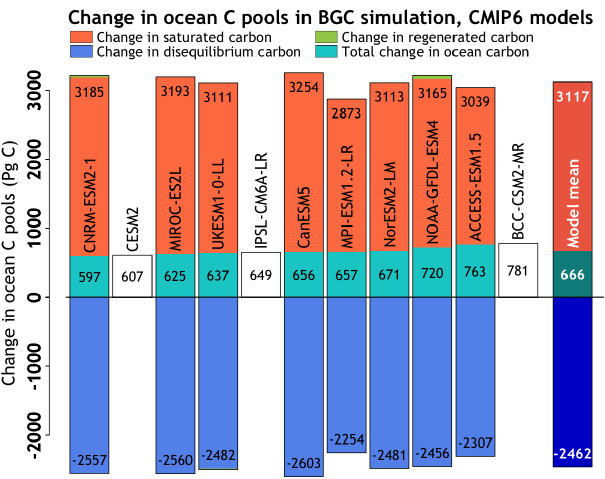
Figure 12. Carbon uptake over the ocean in the biogeochem- ically coupled simulation, used to calculate the ocean carbon– concentration feedback and its partitioning into saturated, dise- quilibrium, and regenerated carbon pools across the participating CMIP6 models (left) using Eq. (12). No partitioning is shown for models for which 3D ocean fields were not available, and the results of these models are not used in calculating the model mean values (right). The sum of the partitions does not exactly match the total ocean uptake diagnosed from the air–sea fluxes due to land–ocean interactions involving storage in sediments and river